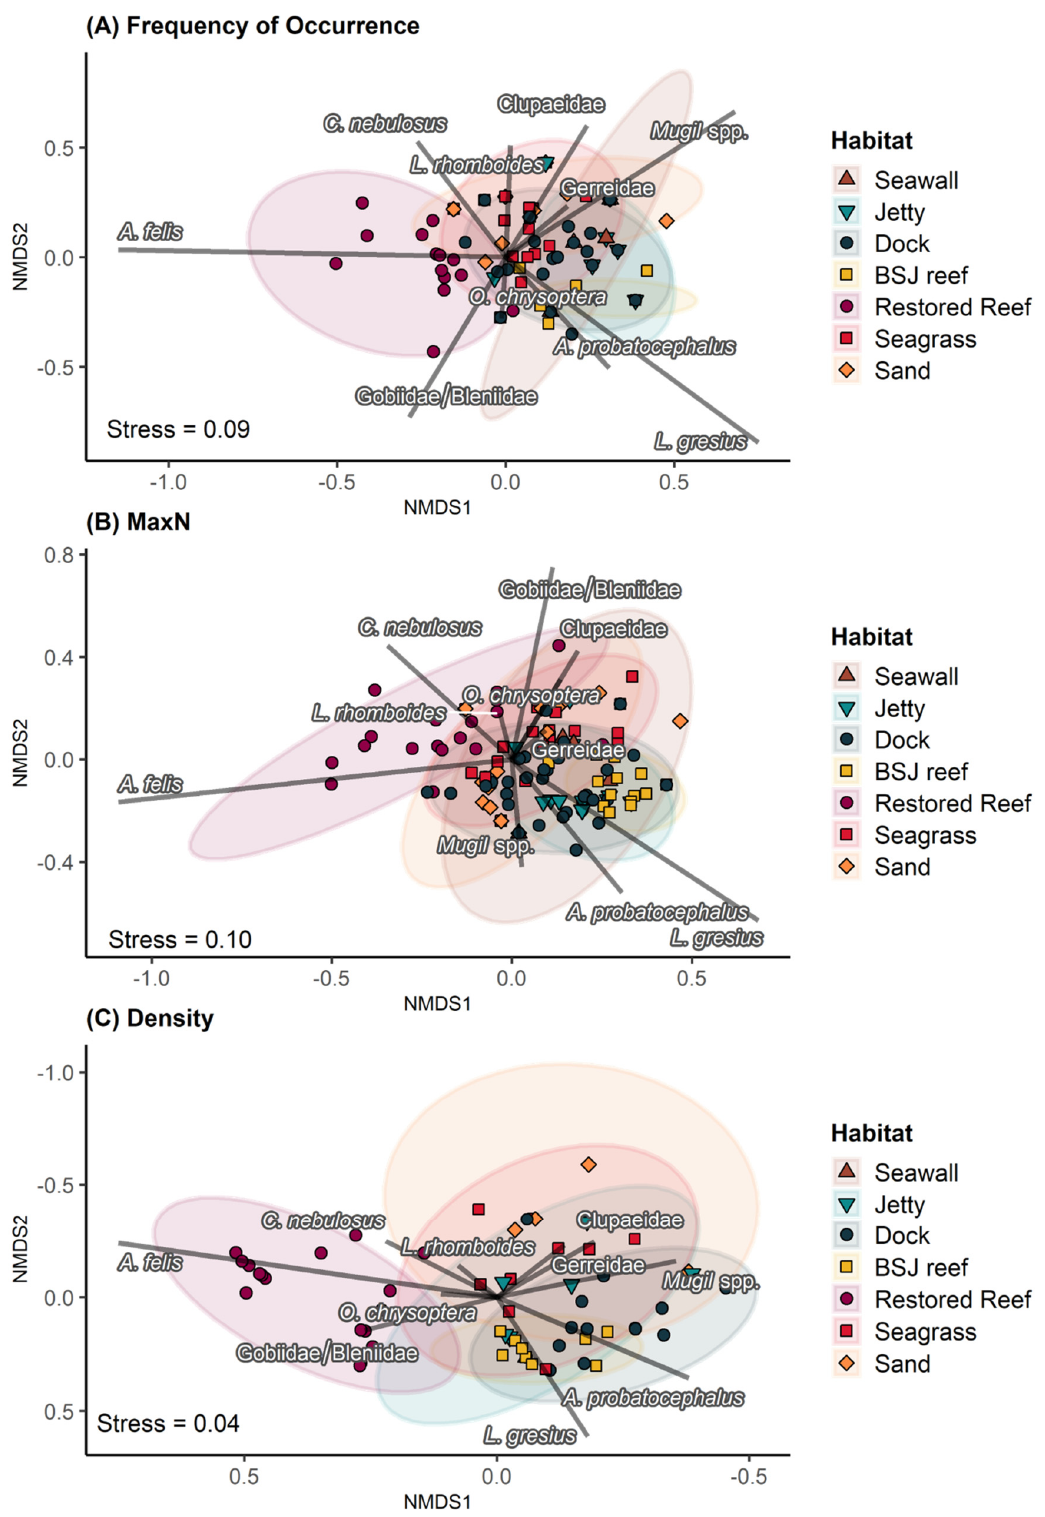
Figure 3. Non-metric multidimensional scaling (nMDS) ordination for the dissimilarity between fish assemblages as determined from ( A ) Frequency of Occurrence, ( B ) MaxN, and ( C ) Density. Sample symbols correspond to the sampled habitat. Only the taxa present in ≥ 5% of non-empty videos were included in the analysis. Community vectors were fit onto the ordination space and standard deviation ellipses show 95% confidence areas for the ordination space of each habitat. Note that for ( C ) Density, there is no ellipse for Seawall as n = 1. Symbol colors as per Figure 1